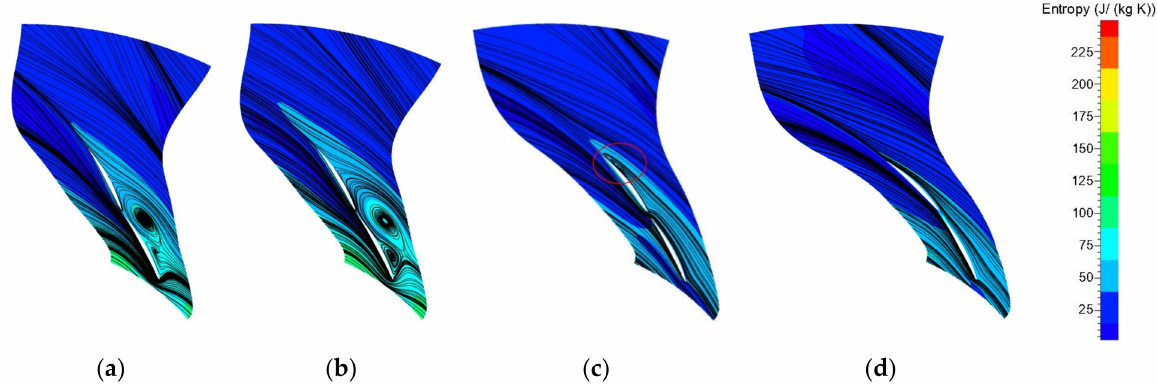
Figure 10. Entropy and streamline distribution at 90% span in different cases. ( a ) 0 ◦ model; ( b ) 3 ◦ model; ( c ) 10 ◦ model; and ( d ) 18 ◦ model.